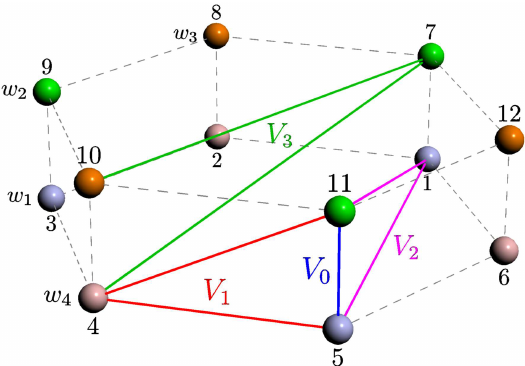
Figure 2: 12-site cluster used in this work. The extended interactions V shown. Different Wannier orbitals are shown as spheres of different colors. Orbitals w and w are located, say, on the bottom layer, whereas orbitals w 1 4 located on the top layer.